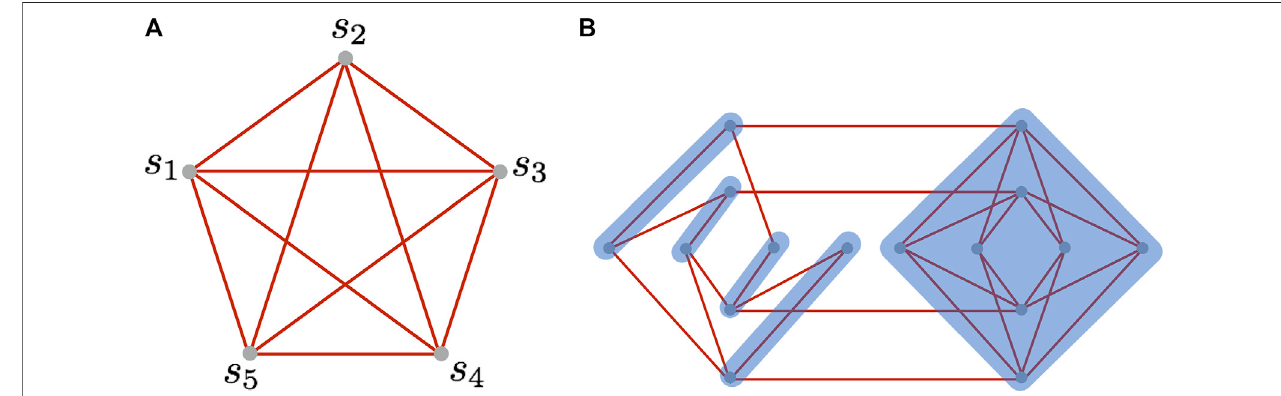
FIGURE9| ( A )Pentagramspinnetworkwith N (cid:2) 5.Eachlinkofthegraphislabeledwith j (cid:2) 1 / 2.Thequbits(heremodeledbytheclassicalbits s i )arede fi nedatthe nodes. (B) An exemplary embedding of the pentagram spin network on the two neighbor blocks of the D-Wave processor. The shadowed regions represent collective (chain) qubits which correspond to the nodes of the spin network.